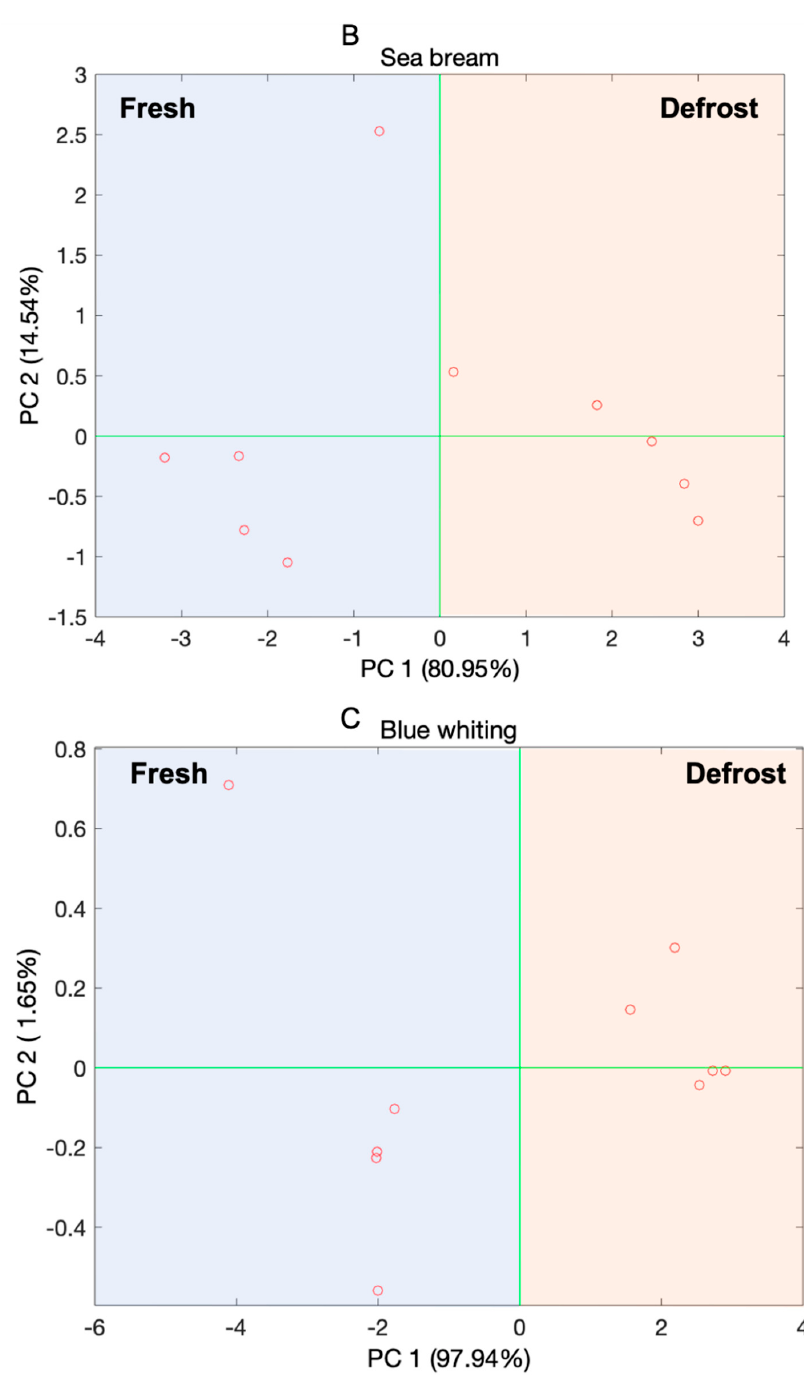
Figure 9. Scores plot of the first two principal components (PCs) of the PCA models elaborated on the dataset registered by the BIONOTE-V in the analysis of the samples of fishes pertaining the three species considered for the experiment: ( A ) codfish; ( B ) sea bream; ( C ) blue whiting. Along the most informative PC (the PC1) a clear discrimination can be observed among the fresh and defrosted samples of each species.